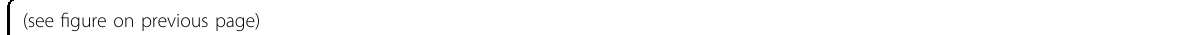
Fig. 7 Expression of RANKL , c-Myb, and Sry in human bone tissues is dependent on gender and health state. qPCR was used to measure gene expression in human bone samples from male osteoporotic (OP, n = 12), osteoarthritic (OA, n = 13) and healthy (ctl. n = 12) patients and from female osteoporotic (OP, n = 46) and osteoarthritic (OA, n = 29) patients. Mean mRNA levels were normalized to RPLP0. Asterisk, signi fi cant differences between groups. a Comparison of RANKL gene expression in bone samples from male and female patients. b Comparison of RANKL gene expression in bone samples from OP, OA, and ctl male patients. c Comparison of RANKL gene expression in bone samples from OP and OA female patients. d Comparison of Sry gene expression in bone samples from OP, OA, and ctl male patients. e Comparison of c- Myb gene expression in bone samples from OP, OA, and ctl male patients. f Comparison of c- Myb gene expression in bone samples from OP and OA female patients. g Comparison of c- Myb gene expression in bone samples from male and female patients. h Comparison of Sry : c- Myb expression ratios in bone samples from OP, OA, and ctl male